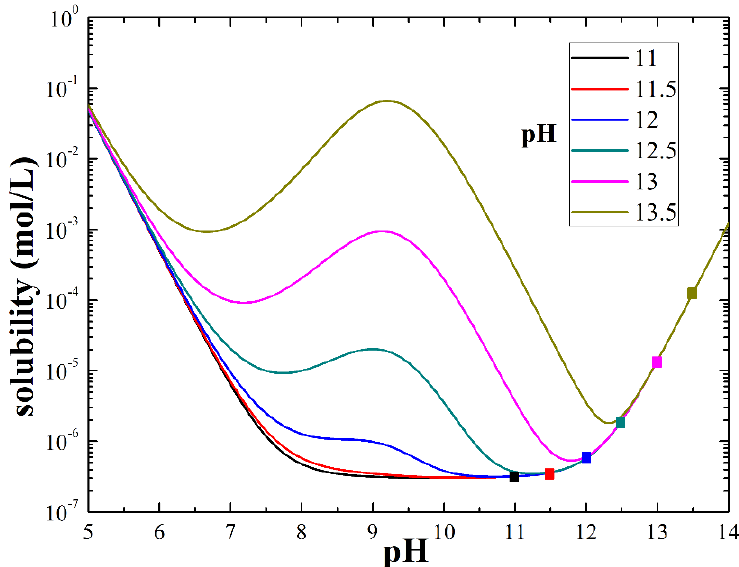
Figure 2. Solubility diagrams obtained at 25 °C for each pH value fixed by the ammonium hydroxide (NH 4 OH) concentration.